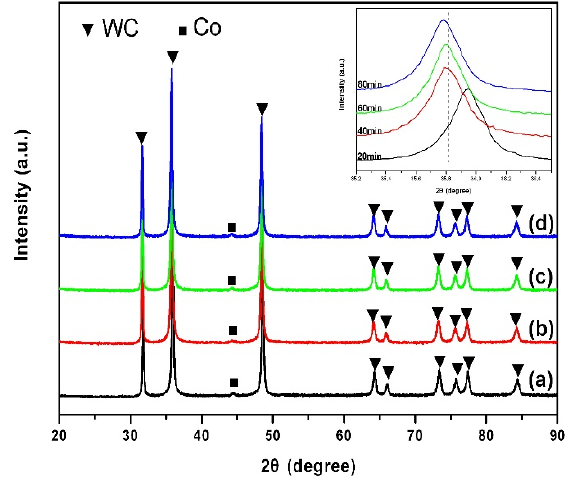
Figure 2. XRD patterns of the specimens sintered at 1300 °C for different holding times: ( a ) 20 min; ( b ) 40 min; ( c ) 60 min; ( d ) 80 min.